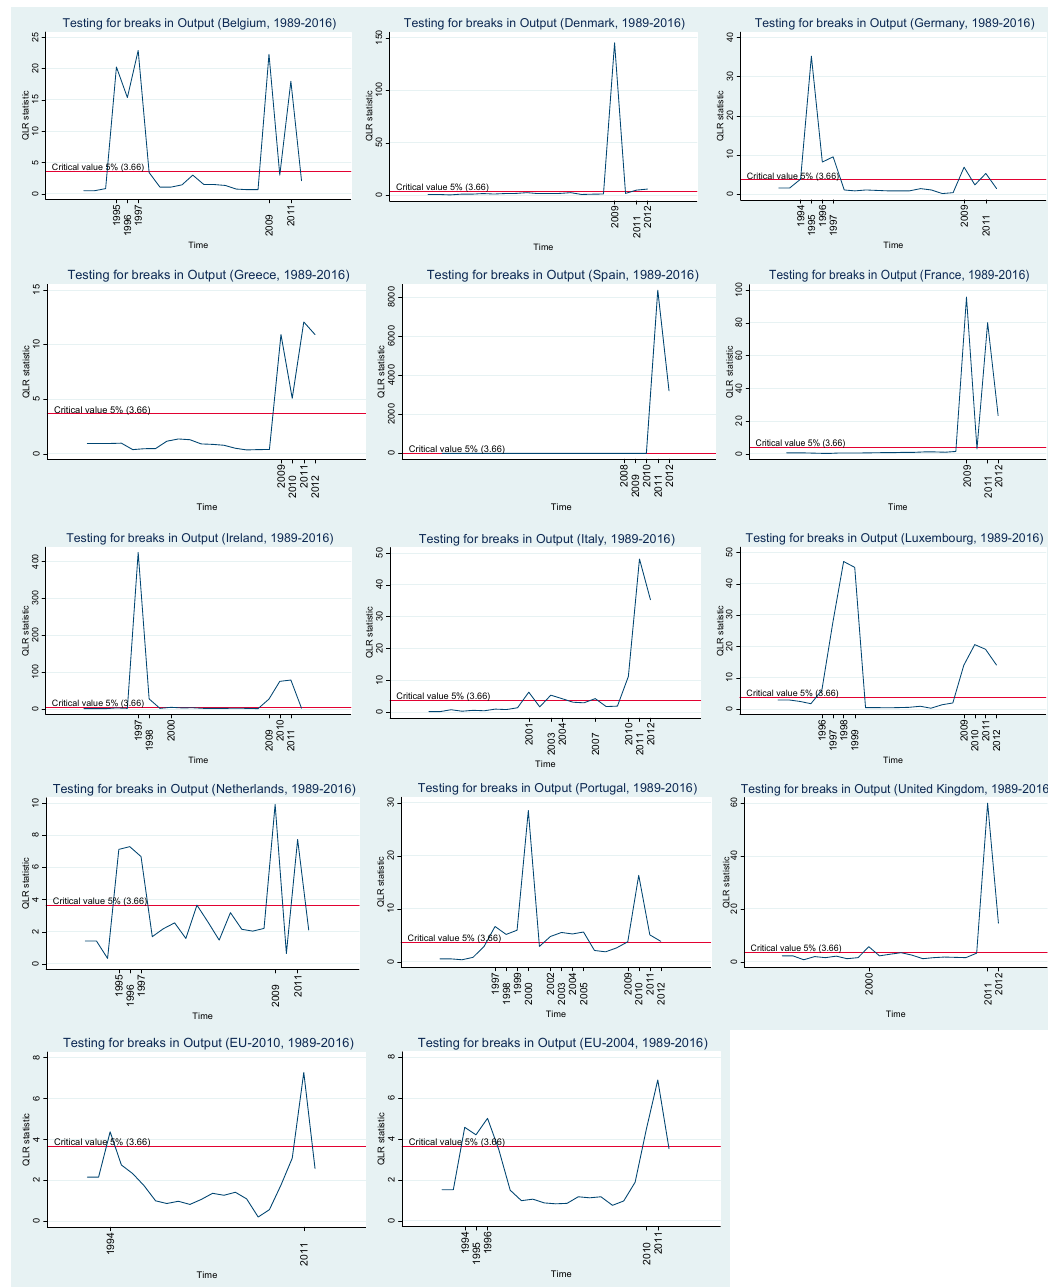
Figure 5. Testing for breaks in total output (euros) over the European Union countries (1989–2016).